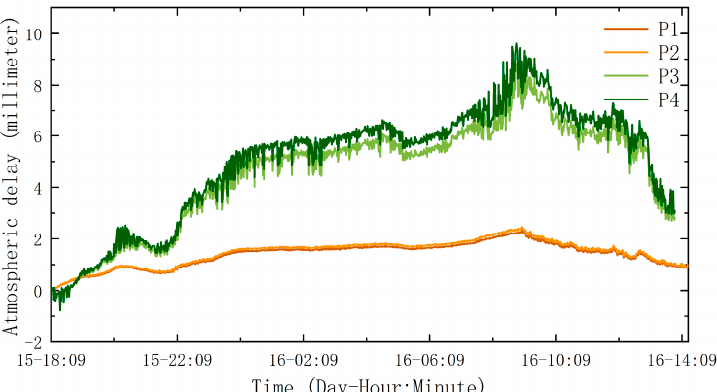
Figure 4. The atmospheric delay for the four re fl ectors P 1 , P 2 , P 3 , and P 4 calculated from the meteor- ological